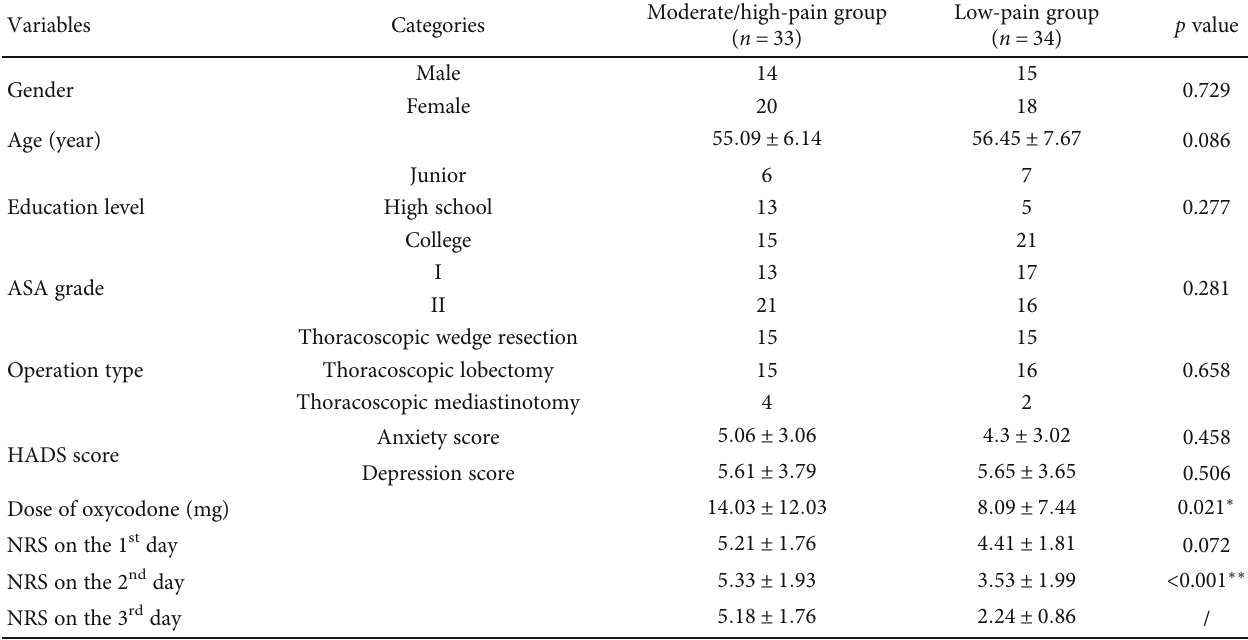
Table 1: Participant demographic information and postoperative pain.